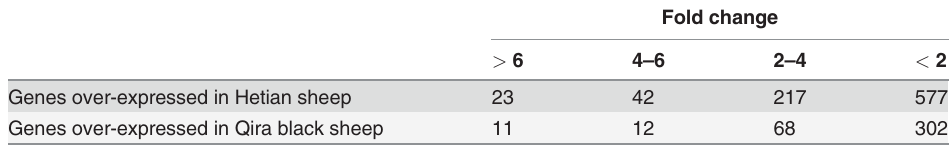
Table 3. Fold change differences in expression of genes differentially expressed between the two sheep at FDR < 0.001. Fold change > 6 4 – 6 2 – 4 < 2 Genes over-expressed in Hetian sheep 23 42 217 577 Genes over-expressed in Qira black sheep 11 12 68